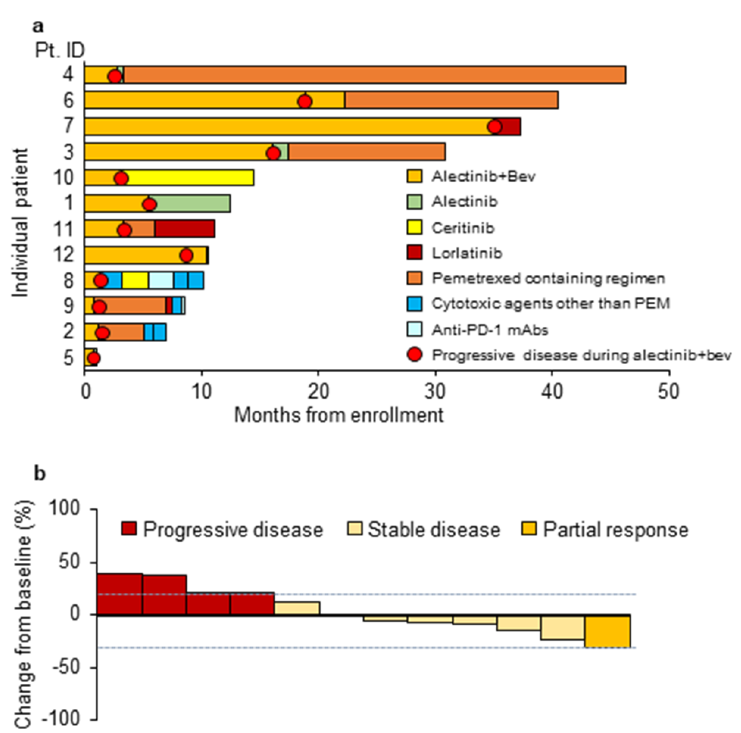
Figure 2. Swimmer and waterfall plots ( a ) Swimmer plot showing duration of response. Each bar represents one patient. ( b ) Waterfall plots of percent change from baseline in measurable tumors at the time of the best response. Pt; patient, PD-1; programmed cell death-1, mAbs; monoclonal anti- bodies.